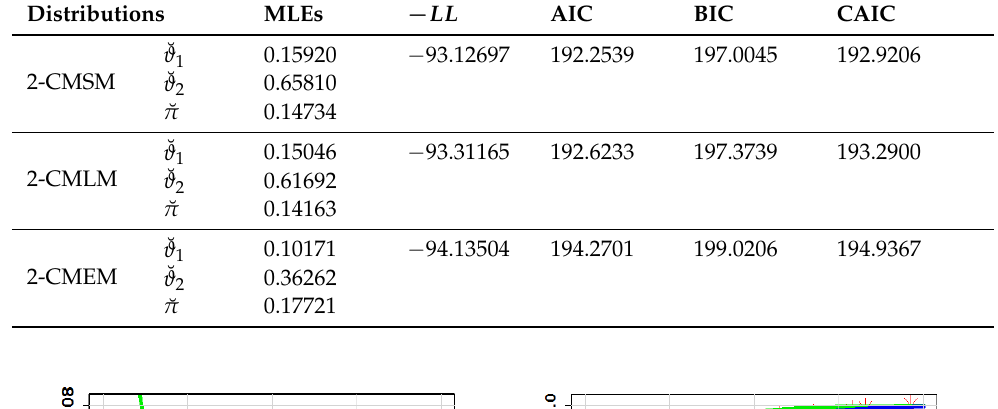
Table 2. MLEs, and GOF statistics for the Dataset II.